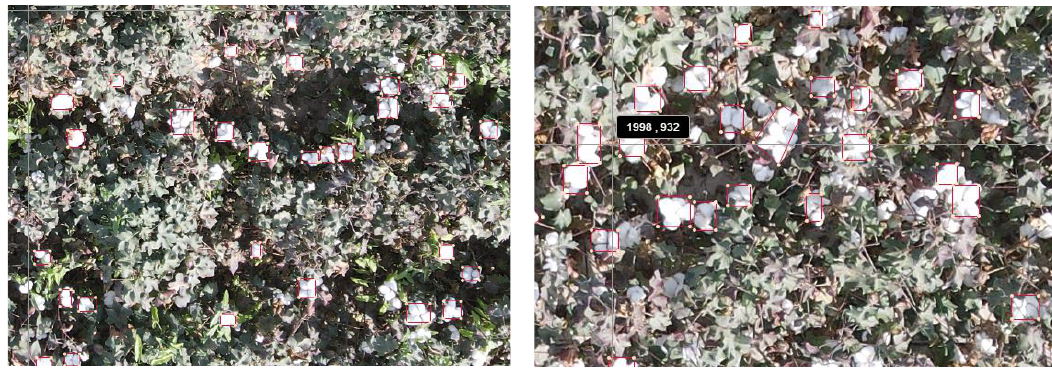
Figure 4. Image annotation.